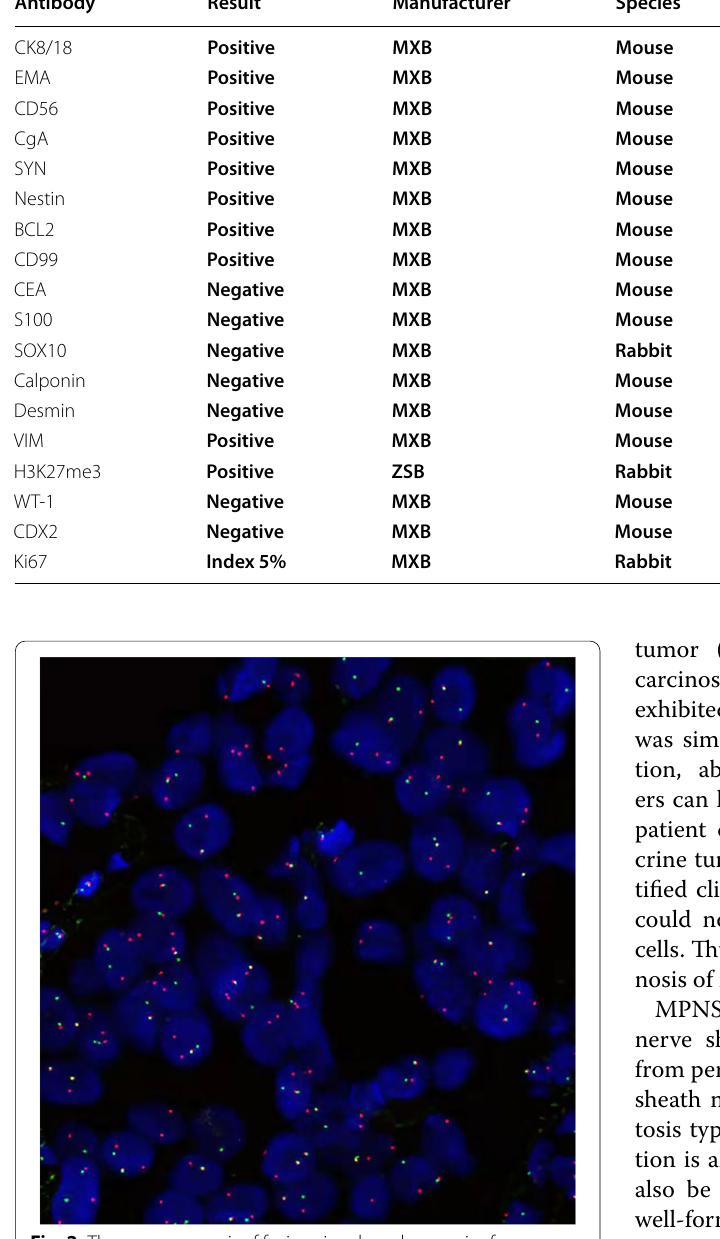
lesion, specifically synovial sarcoma, and molecular